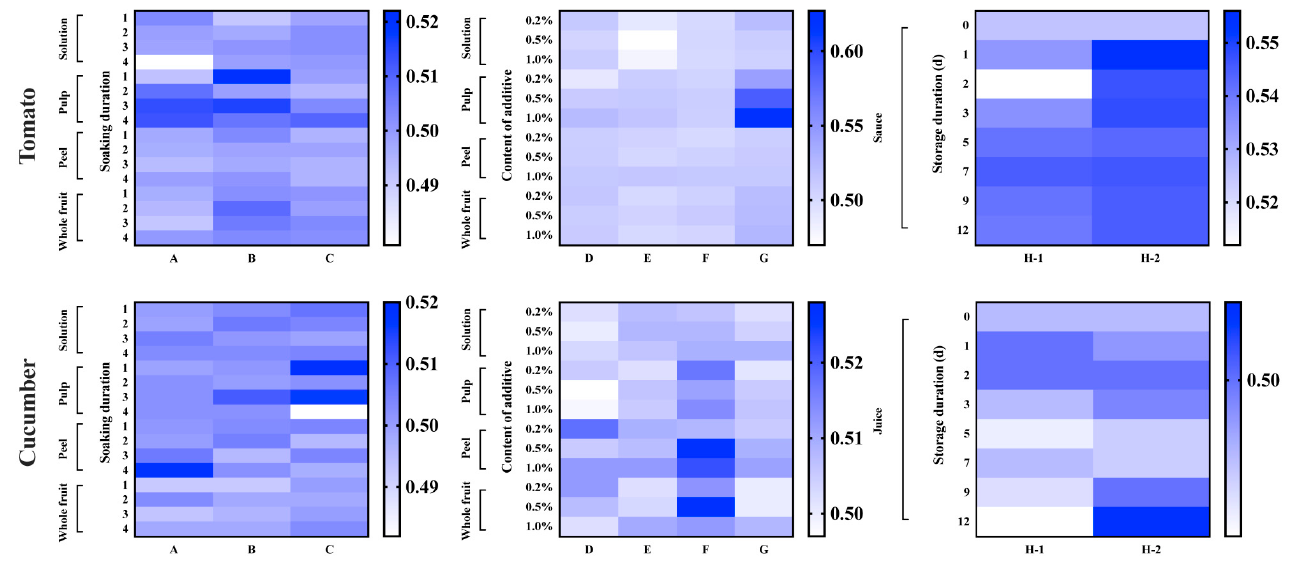
Figure 4. Heatmap of EF values of penthiopyrad in processed tomato and cucumber samples by different soaking methods (A: water soaking and peeling (1, 2, 3, 4 represented 5, 10, 15, 20 min); B: heated water soaking and peeling (1, 2, 3, 4 represented 5, 10, 15, 20 min); C: ultrasound-assisted soaking and peeling (1, 2, 3, 4 represented 4, 6, 8, 10 min); D: water soaking with NaCl and peeling; E: water soaking with AA and peeling; F: water soaking with LAS and peeling; G: water soaking with EA and peeling) and saucing or juicing in different durations at 4 °C (H-1) and room temperature (H-2).